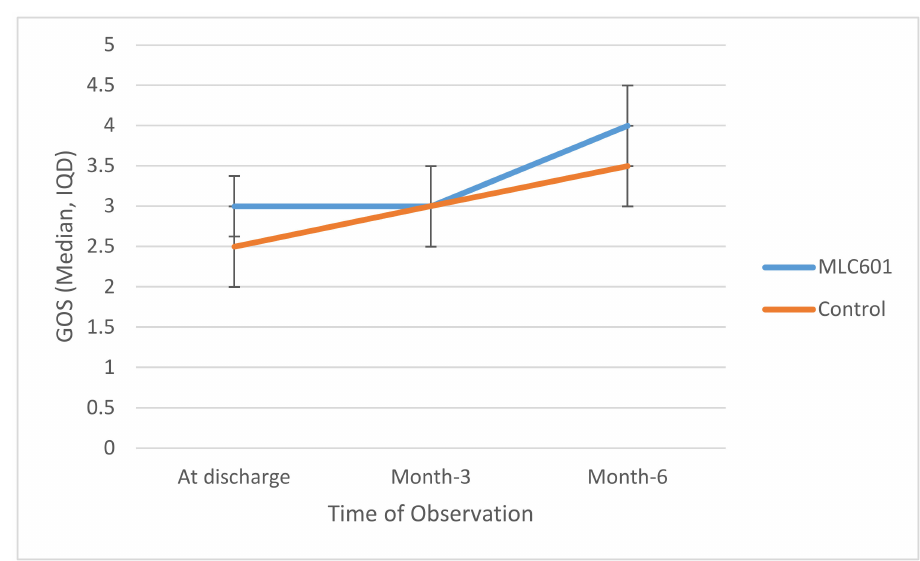
Figure 1. Trajectories of GOS over time between groups.